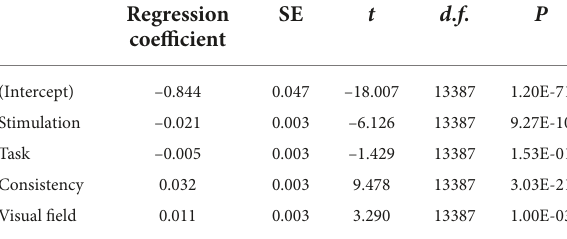
TABLE 2 Multilevel model for pupil constriction